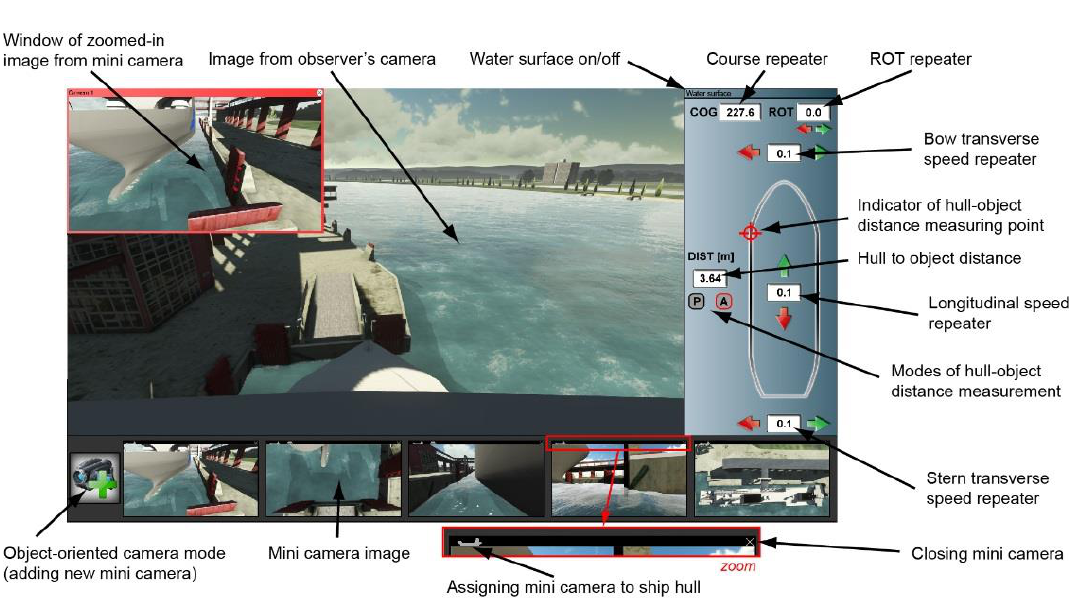
Figure 11. The augmented interface of the SDSS.